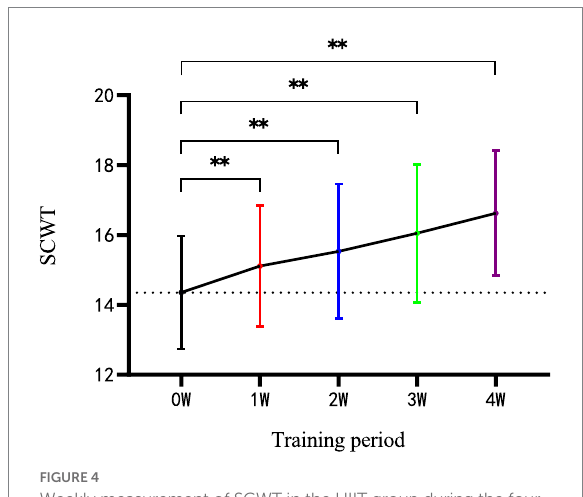
FIGURE 4 Weekly measurement of SCWT in the HIIT group during the four- week training group. SCWT, Stroop color-word test; W, week; ** p <